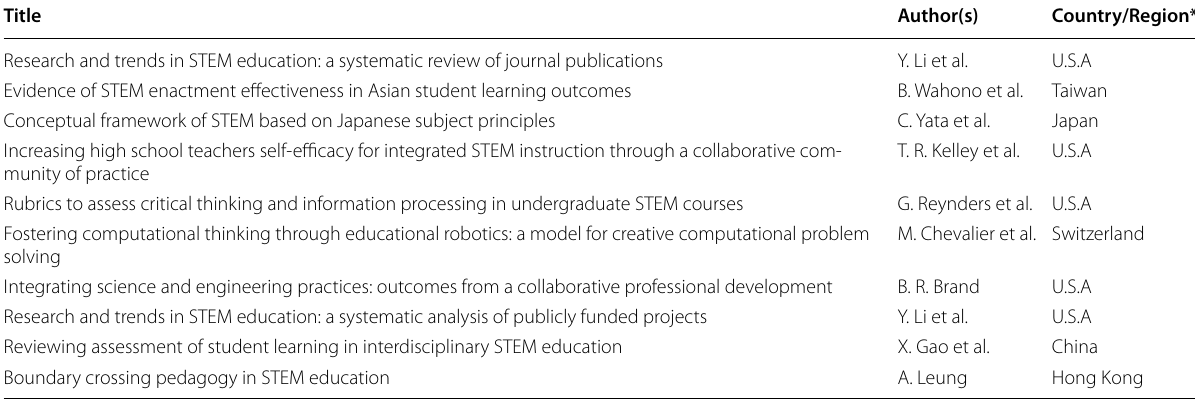
Table 2 Top 10 most‑cited articles published in